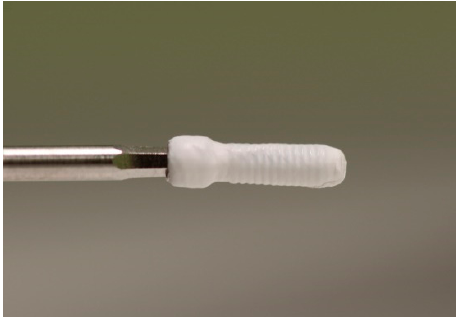
Figure 2. Prosthetic screw wrapped in polytetrafluorethylene (PTFE).